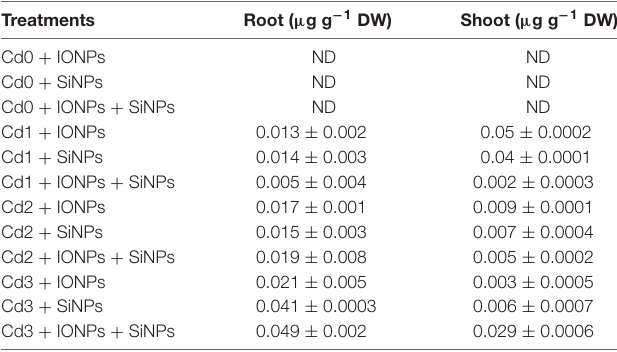
TABLE 2 | Effect of IONPs and SiNPs on root Cd content, shoot Cd content, translocation factor, and metal tolerance index of Phaseolus vulgaris grown in different concentrations of Cd.